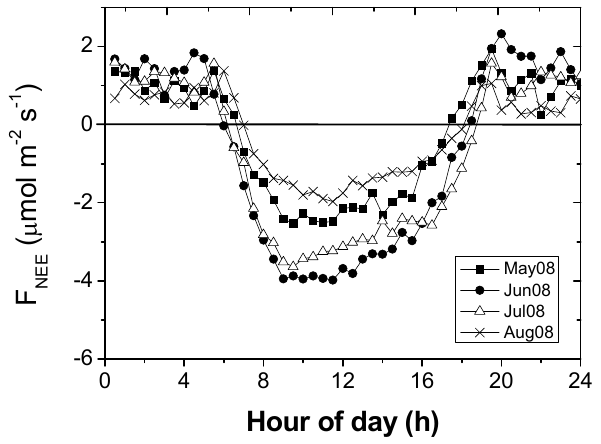
Fig. 5b. Mean hourly NEE flux vs. PPFD during June, July and Au- gust 2008. Hysteresis was found for every month, with the temporal trend proceeding counterclockwise. May was removed for lack of